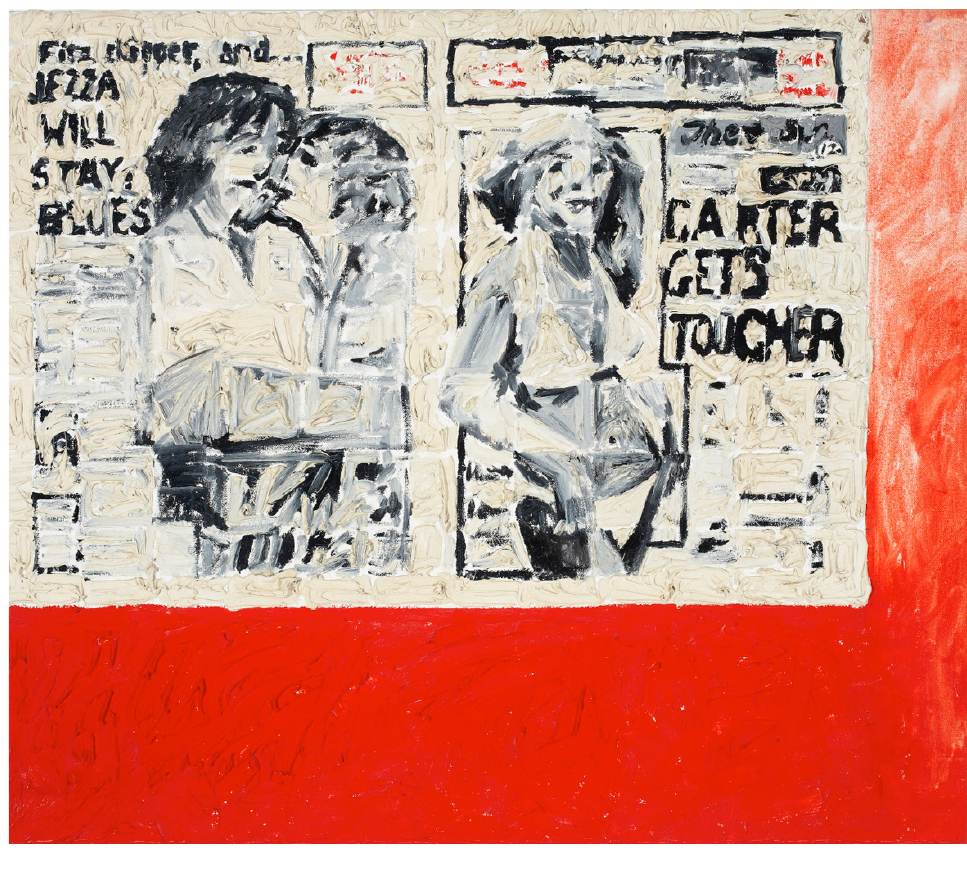
Jenny Watson, A Painted Page: The Sun Jezza Will Stay, Blues, [1980], oil on cotton duck, 58 x 67.6 cm. Collection of the artist, courtesy of Anna Schwartz Gallery. Copyright Jenny